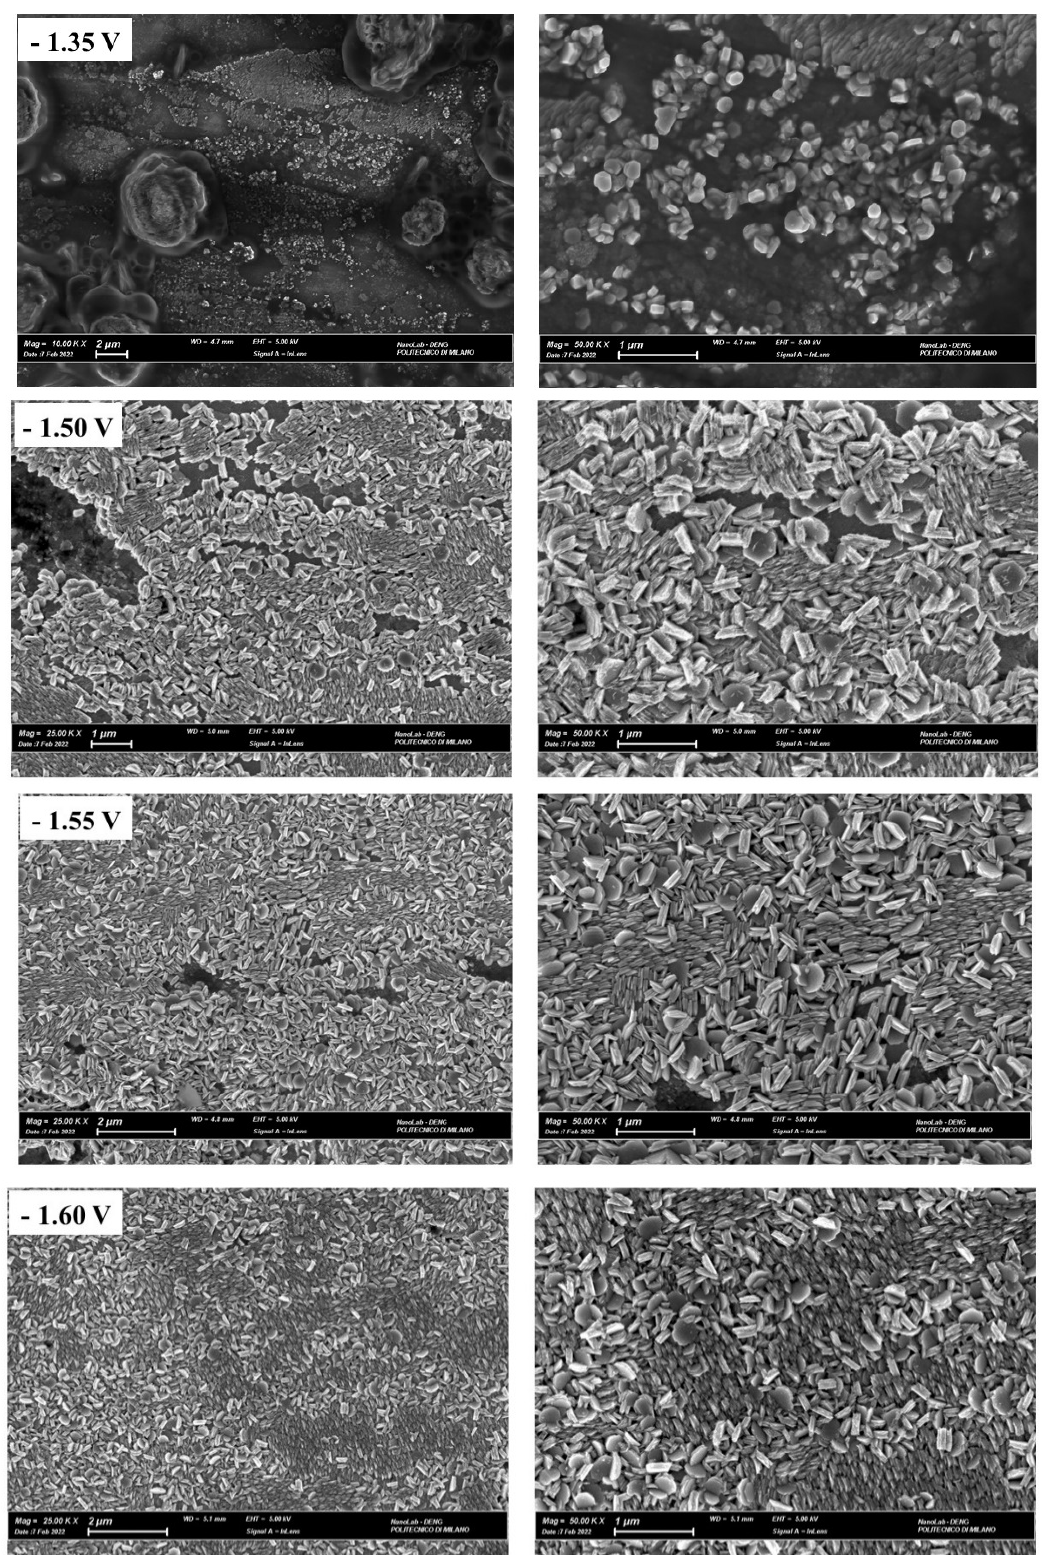
Figure 10. SEM images of Zn electrodeposits were potentiostatically obtained on polycrystalline Zn at E = −1.35, −1.50, −1.55 and −1.60 V from 0.3 M ZnSO 4 in DES ChU. Electrodeposition time: 900 s.